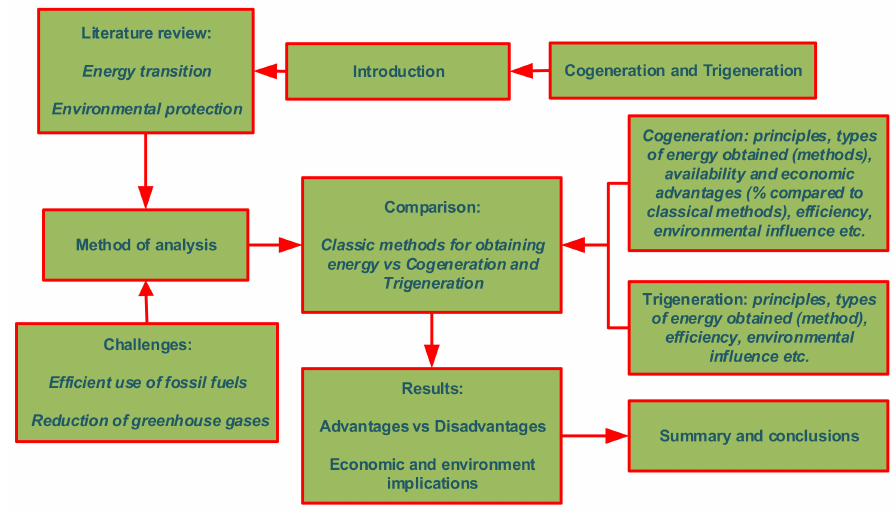
Figure 1. General chart of the present study. Source: the authors based on selected scientific